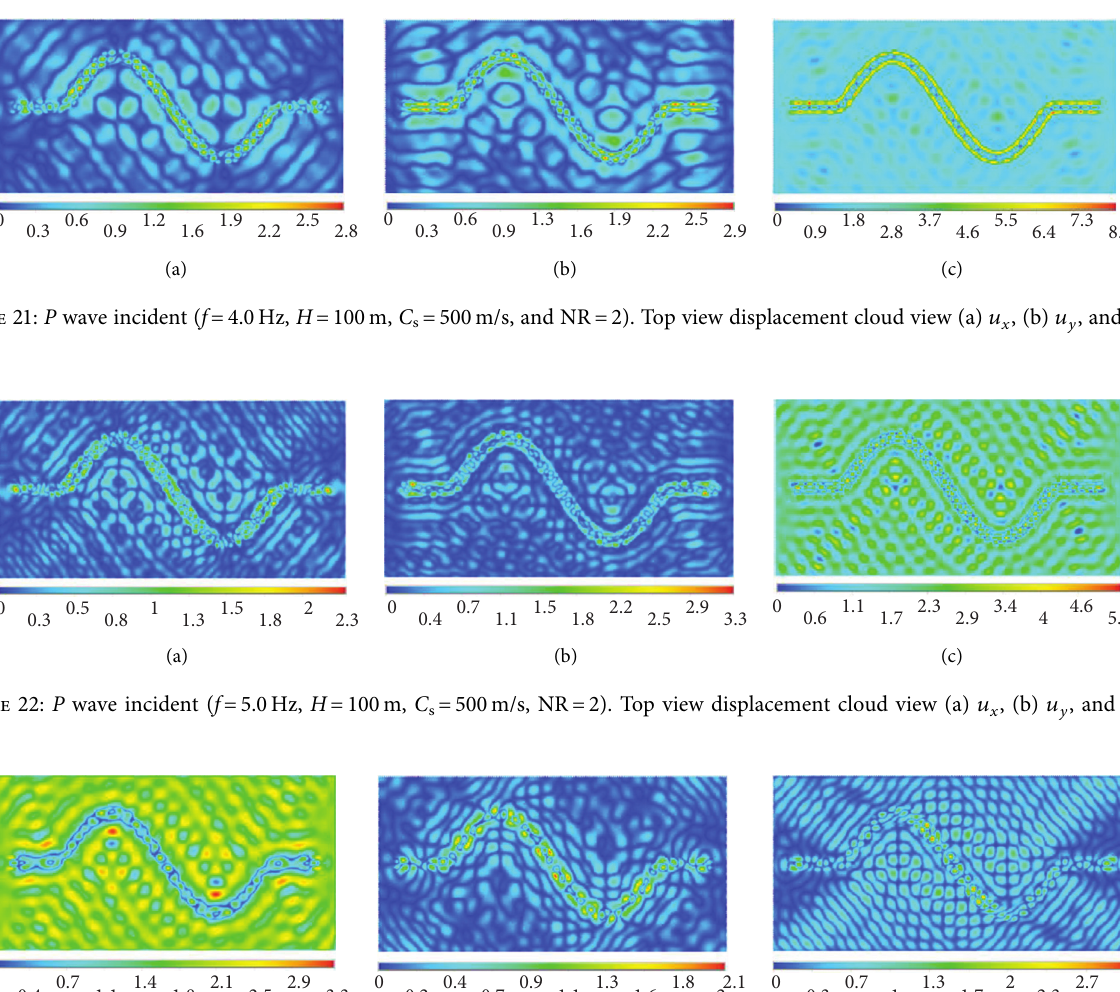
� 500m/s, NR � 2). Top view displacement cloud view (a) u s